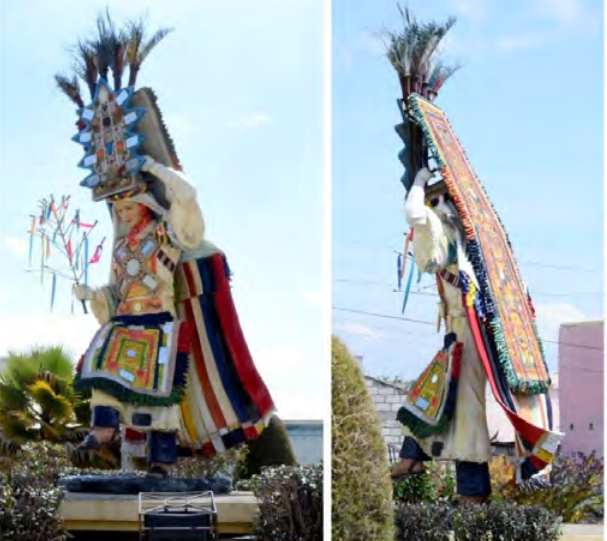
Figure 1. Corpus Christi Dancer